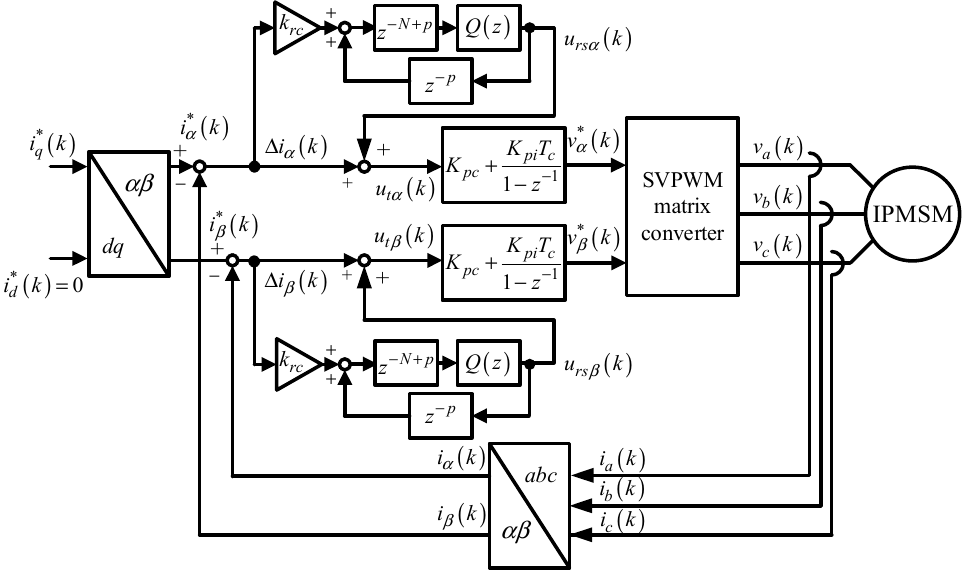
Figure 6. The CPC current-loop control for an IPMSM drive.